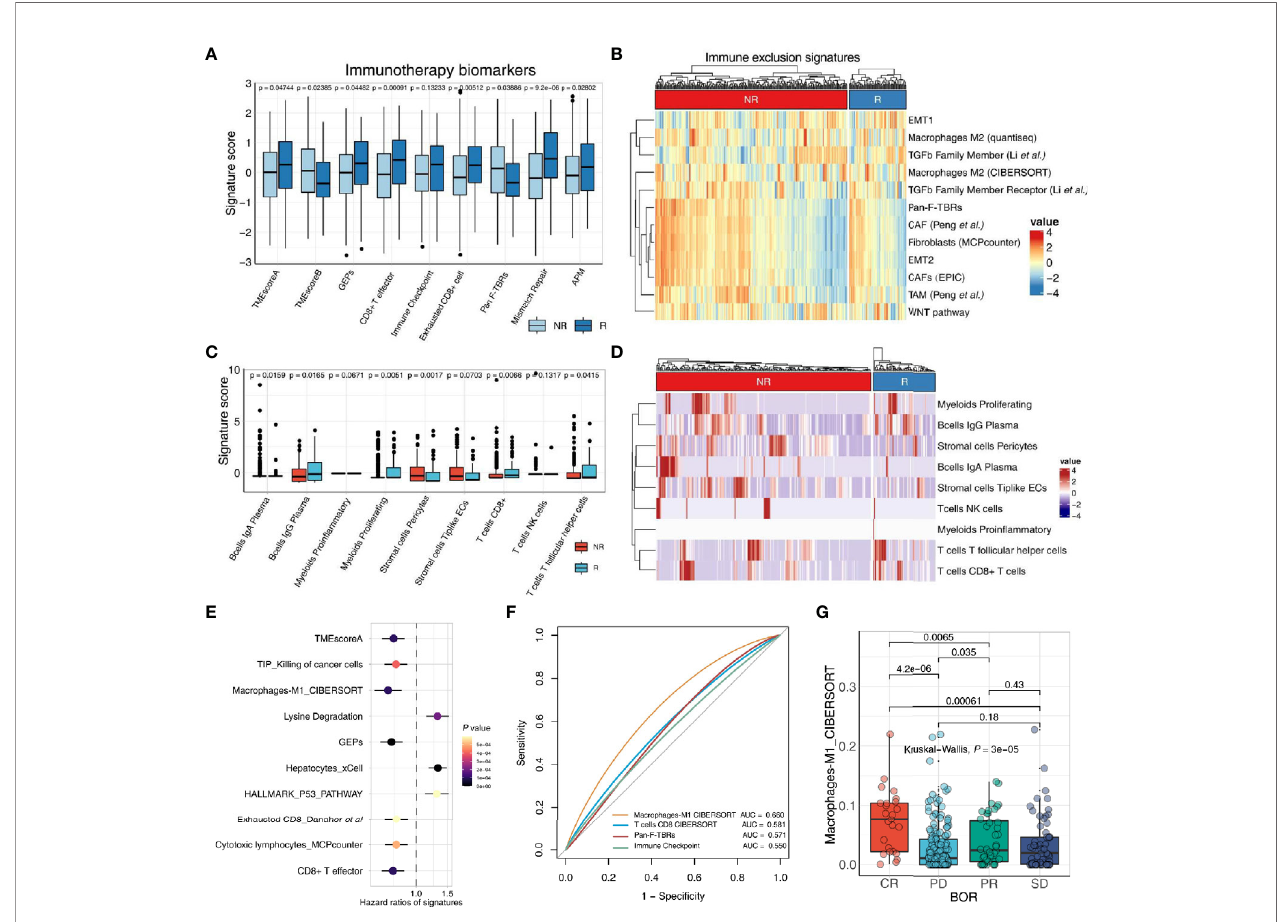
FIGURE 3 | IOBR deciphers TME components and phenotype related signatures derived from bulk-seq and scRNA-seq data. (A, B) The boxplot (A) and heatmap (B) delineate the putative biomarkers and TME cell signatures enrolled in IOBR, and identities signatures associated with immunotherapy best overall response, by implementing IOBR to dissect bulk RNA-seq data of patients in the IMvigor210 bladder cancer cohort. APM, antigen-processing machinery; NR, non-responder; R, responder. (C, D) The boxplot (C) and heatmap (D) leveraging speci fi c cell-type gene expression signatures generated from prior single-cell analysis to decipher the TME landscape of bulk-seq transcriptomic and clinical data in the IMvigor210 cohorts. The patients were classi fi ed by the responses to immune checkpoint inhibition and TME compositions statistically associated with treatment sensitivity. Subsequently, the patients were enumerated and batch visualized. (E, F) IOBR dissected the association between signatures and clinical phenotypes in the IMvigor210 bladder cancer cohort. (E) The forest plot with hazard ratios of multiple signatures, integrated a list of survival analysis outputs. (F) The ROC curve delineated multiple signatures for predicting the immunotherapy response, displayed in the order of their corresponding AUC (Area Under Curve) for effective comparison. (G) The boxplot evaluated the correlation between the macrophage M1 in fi ltration and the therapy response which is a category variable. The statistical discrepancy of the macrophage M1 in fi ltration between any categories was analyzed using the Kruskal – Wallis test and exhibited in the